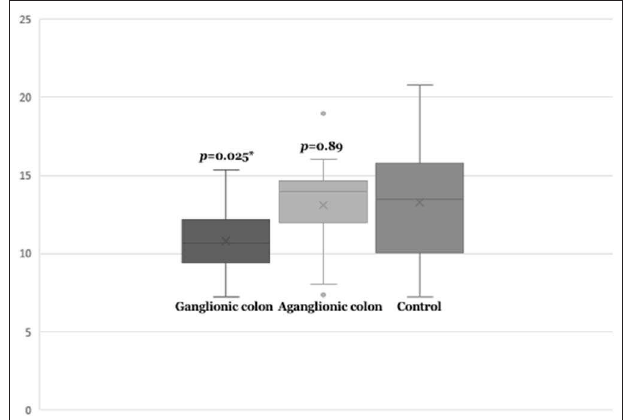
FIGURE 3 | Box-plot graph of 1 C T value of the SEMA3D expressions in HSCR ganglionic colon ( 1 C T 10.8 ± 2.1), HSCR aganglionic colon ( 1 C T 13.4 ± 2.9), and control colon ( 1 C T 13.3 ± 3.9). Box-plot graph of 1 C T value reveals the median values as lines across the box. Lower and upper boxes are representing the 25th percentile to the 75th percentile, while whiskers indicate the maximum and minimum values. * p <